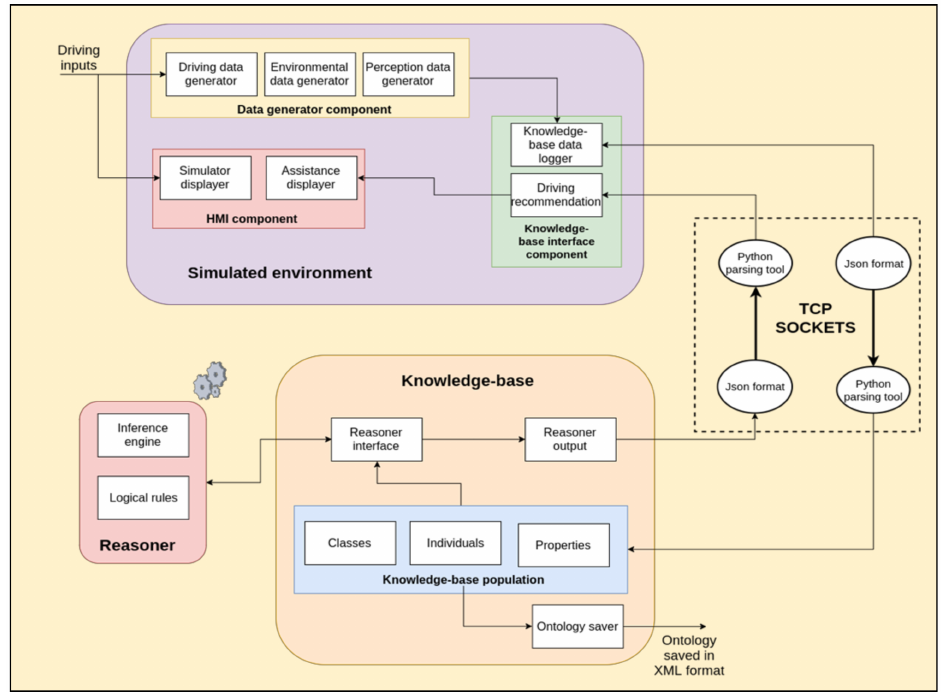
Figure 21. Architecture of the